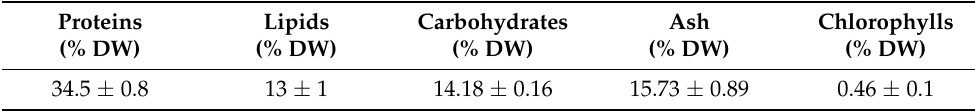
Table 1. Biochemical composition (% of dry weight) of Rhodomonas sp. biomass.